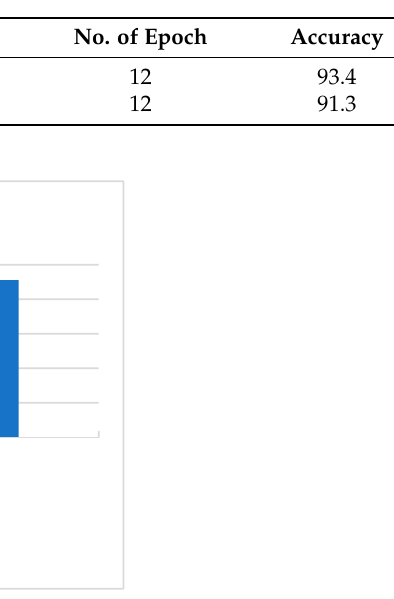
Table 3. Comparison between Adam and SGD optimizer.